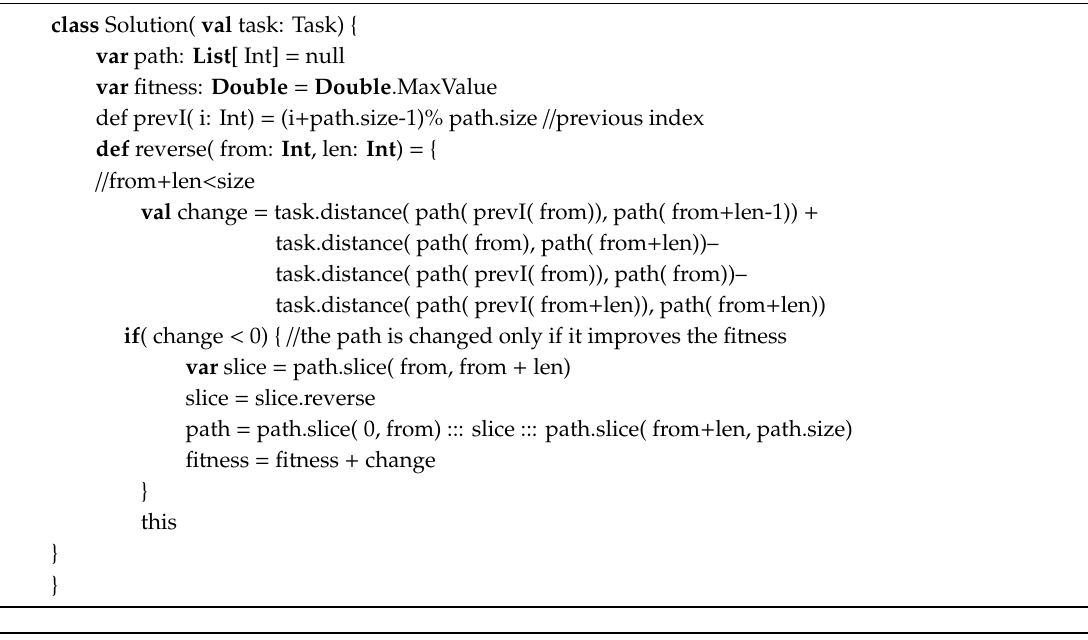
Algorithm 3. Function reverse (in Scala) in class Solution for TSP